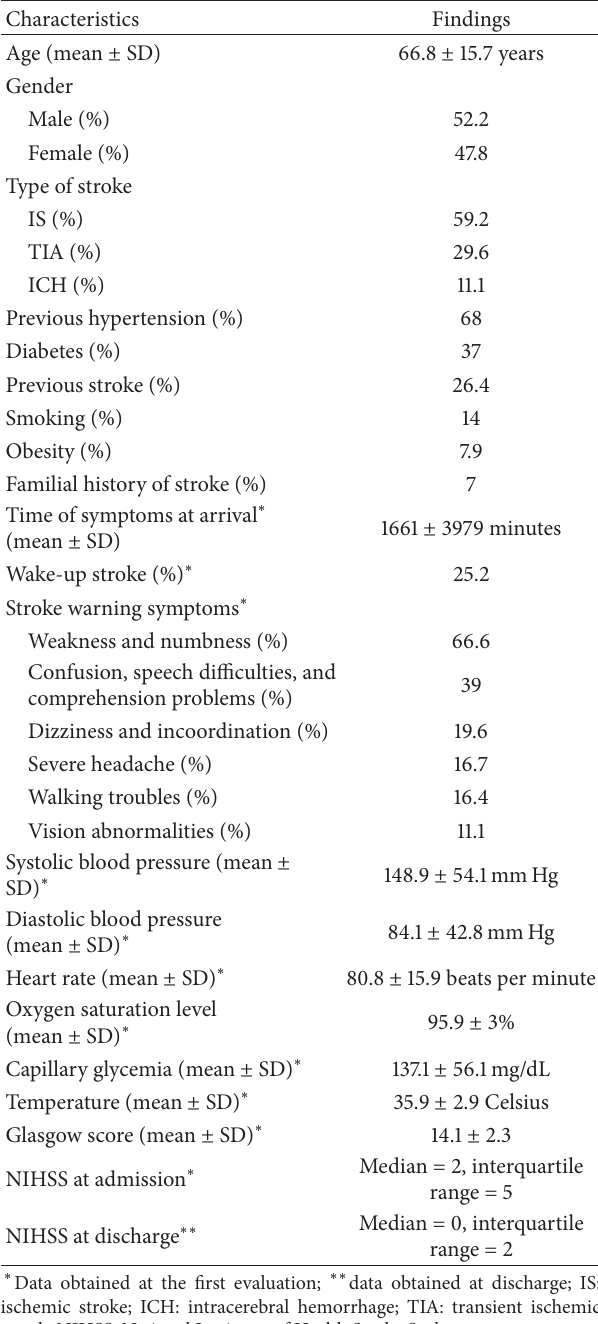
Table 1: Demographical, clinical, and radiological data of the 341 patients included in the